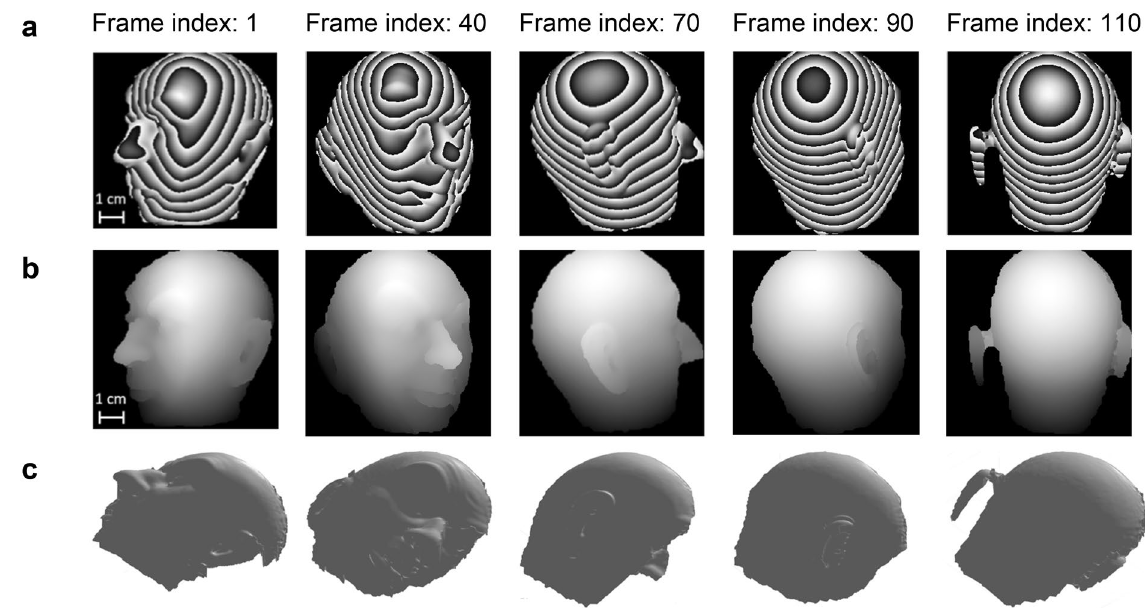
Figure 8. Dynamic 3D surface scanning of a rotating object. ( a ) Wrapped and ( b ) unwrapped phase maps for five selected frames of a rotating head phantom at different stages of object’s rotation. ( c ) 3D visualization of the unwrapped phase